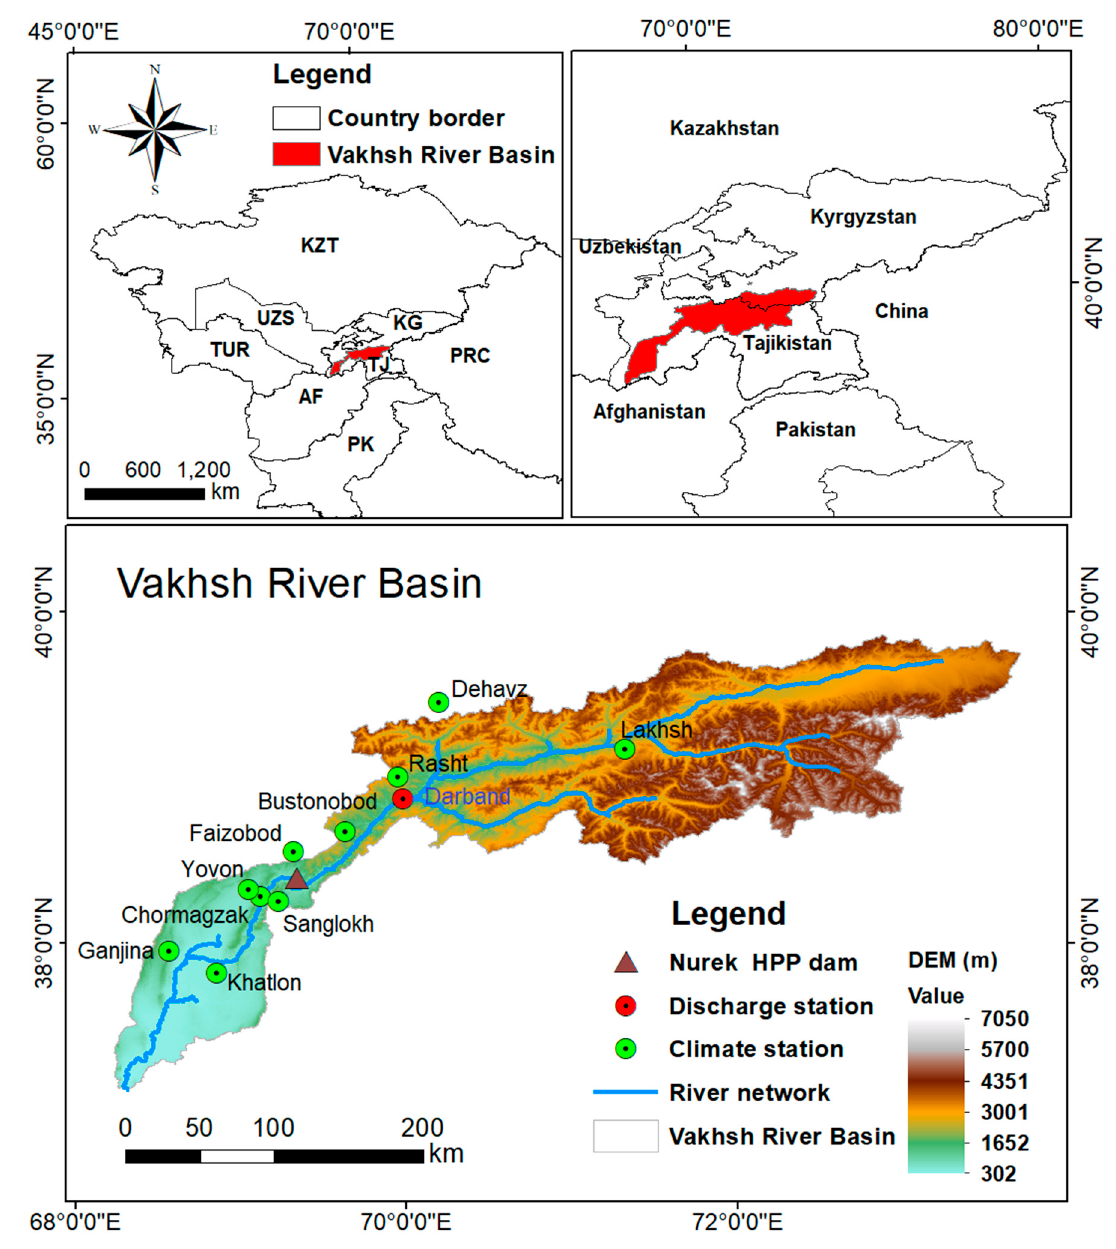
Figure 1. Location of the study area in Central Asia along with hydrological and climate stations. HPP: hydropower plant; DEM: digital elevation model.